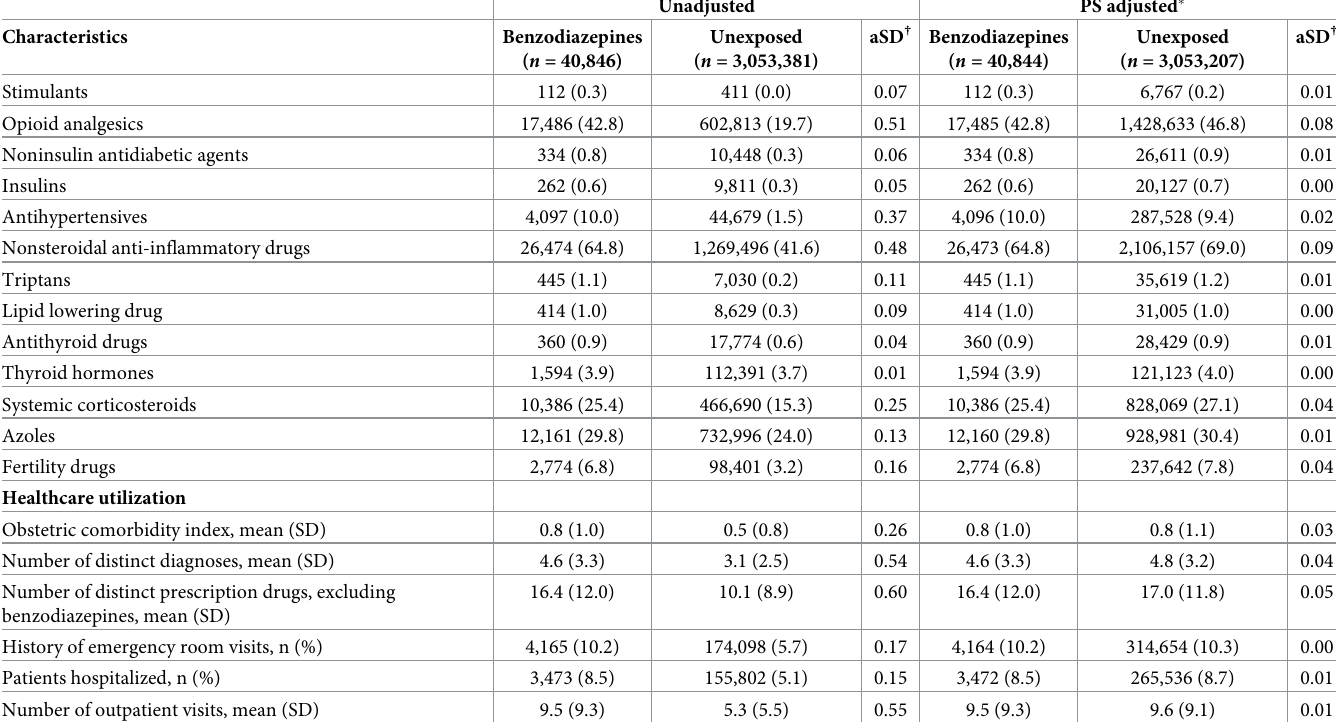
exposed versus 0.7% unexposed had an anxiety disorder; 16.9% exposed versus 1.4% unex- posed received an antidepressant) than the unexposed group. All cohort characteristics were well balanced between the exposed and unexposed groups after PS adjustment, with an aSD < 0.1. The absolute risk difference for overall malformations was 13.9 per 1,000 pregnancies (65.3 versus 51.4 per 1,000 in the exposed and unexposed groups, respectively) and that for heart defects was 11.5 per 1,000 (38.9 versus 27.4 per 1,000) (Fig 1). The PAFs of overall malforma- tions and heart defects were 0.36% and 0.55%, respectively. The unadjusted RRs increased